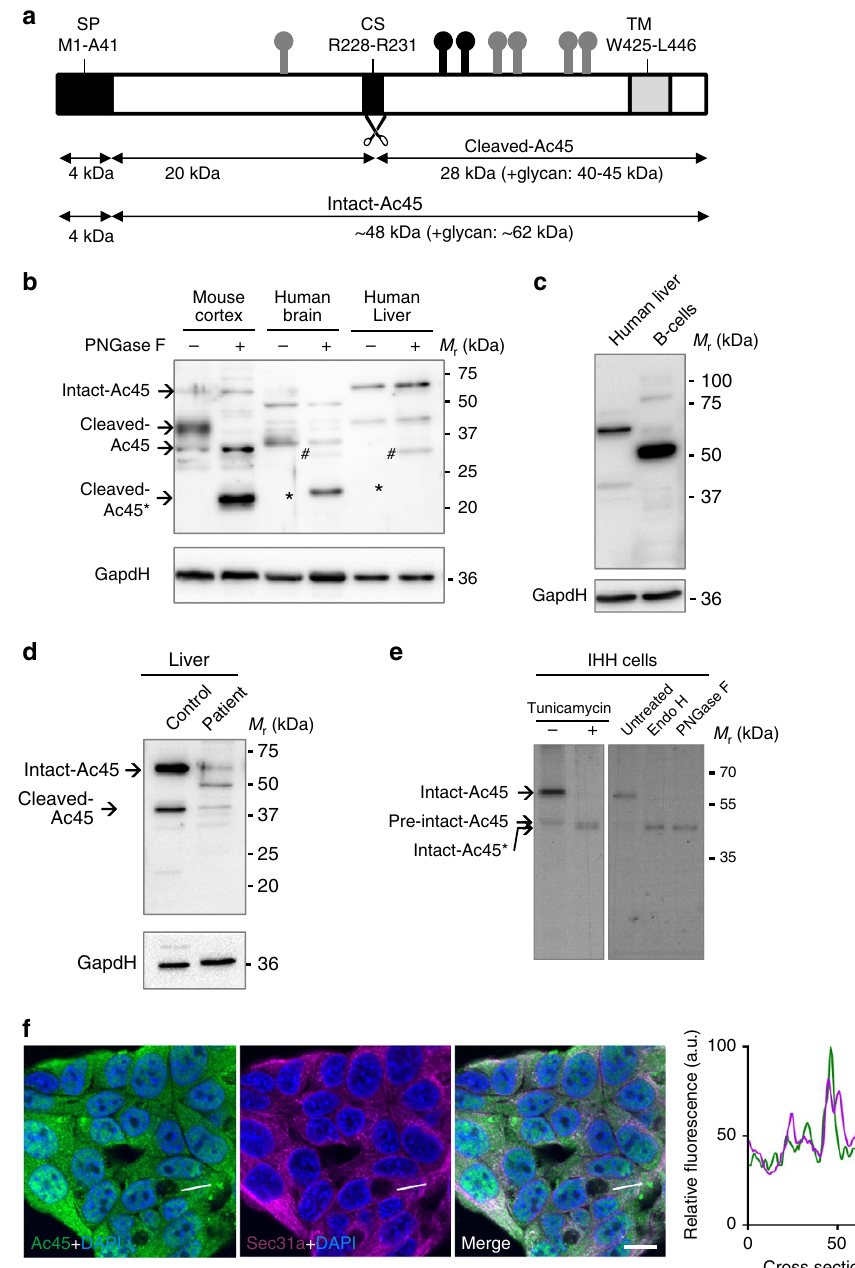
Figure 4 | Differential expression of the Ac45 protein in human brain, liver and B cells. ( a ) Schematic representation of the human Ac45 protein. CS, furin proteolytic cleavage site; SP, signal peptide; TM, transmembrane domain; represent predicted N -glycan structures, whereas the structures shown in black ( ) are the experimentally confirmed glycans 62 . ( b ) Western blot analysis of Ac45 in mouse cortex and in human brain and liver. Asterisk (*) indicates the deglycosylated form of cleaved-Ac45. Hash tags (#) indicate non-specific antibody reaction with PNGaseF present in the samples. ( c ) Western blot analysis of Ac45 in primary B cells from healthy controls in comparison with human liver. One of the two representative analyses is shown. ( d ) Western blot of Ac45 in liver tissue homogenates of control and patient 4.2. GapdH was used as loading control. ( e ) Analysis of newly